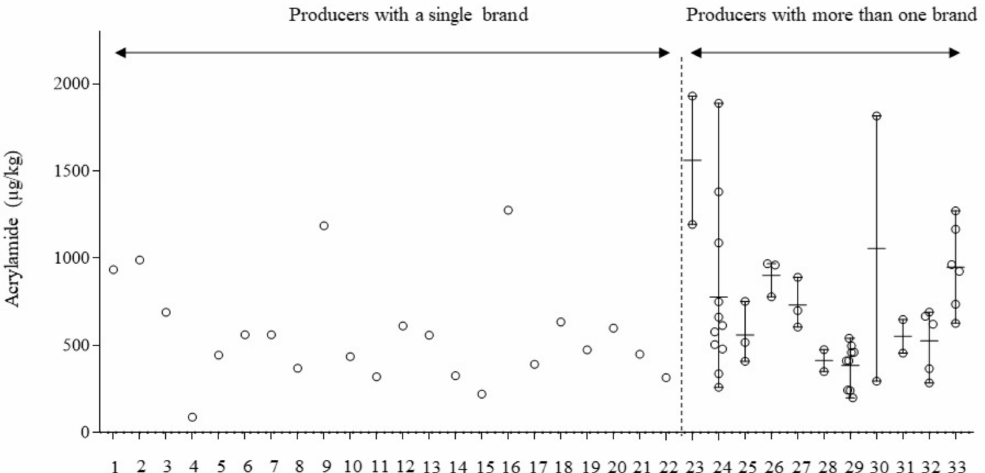
Figure 2. Acrylamide content in potato crisp samples from the Spanish market, grouped according to their producers ( n = 33). Among them: producers with a single brand ( n = 22) and producers with more than one brand ( n = 11). Circles represent individual values; horizontal lines represent mean values and vertical lines represent the range for each